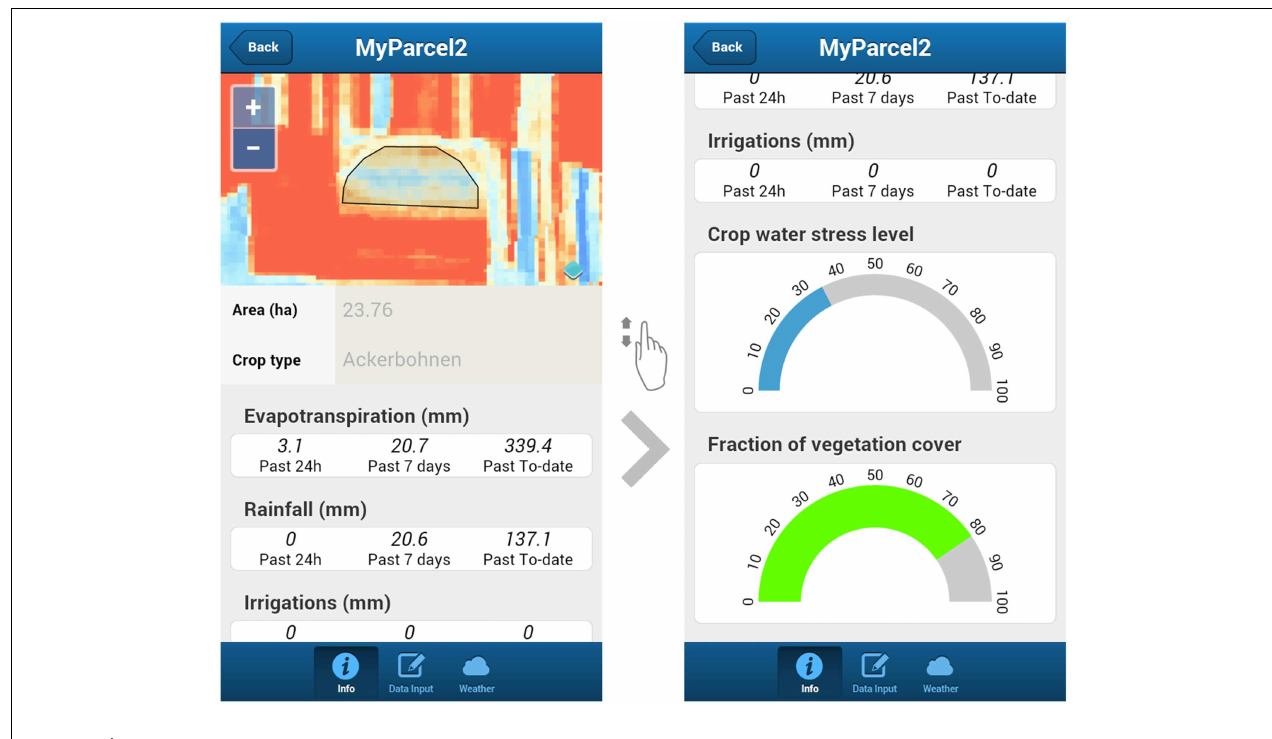
(evapotranspiration, rainfall, provided irrigations). The graphs show the crop water stress level based on the FAO-56 soil water balance model (which is activated only if irrigation inputs are provided) and the fraction of vegetation cover for the